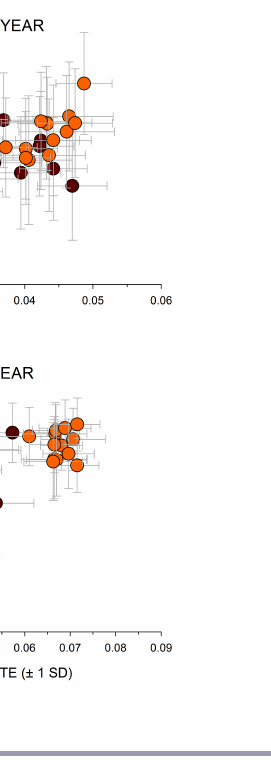
, f using the Markov a*s*t a*s*t